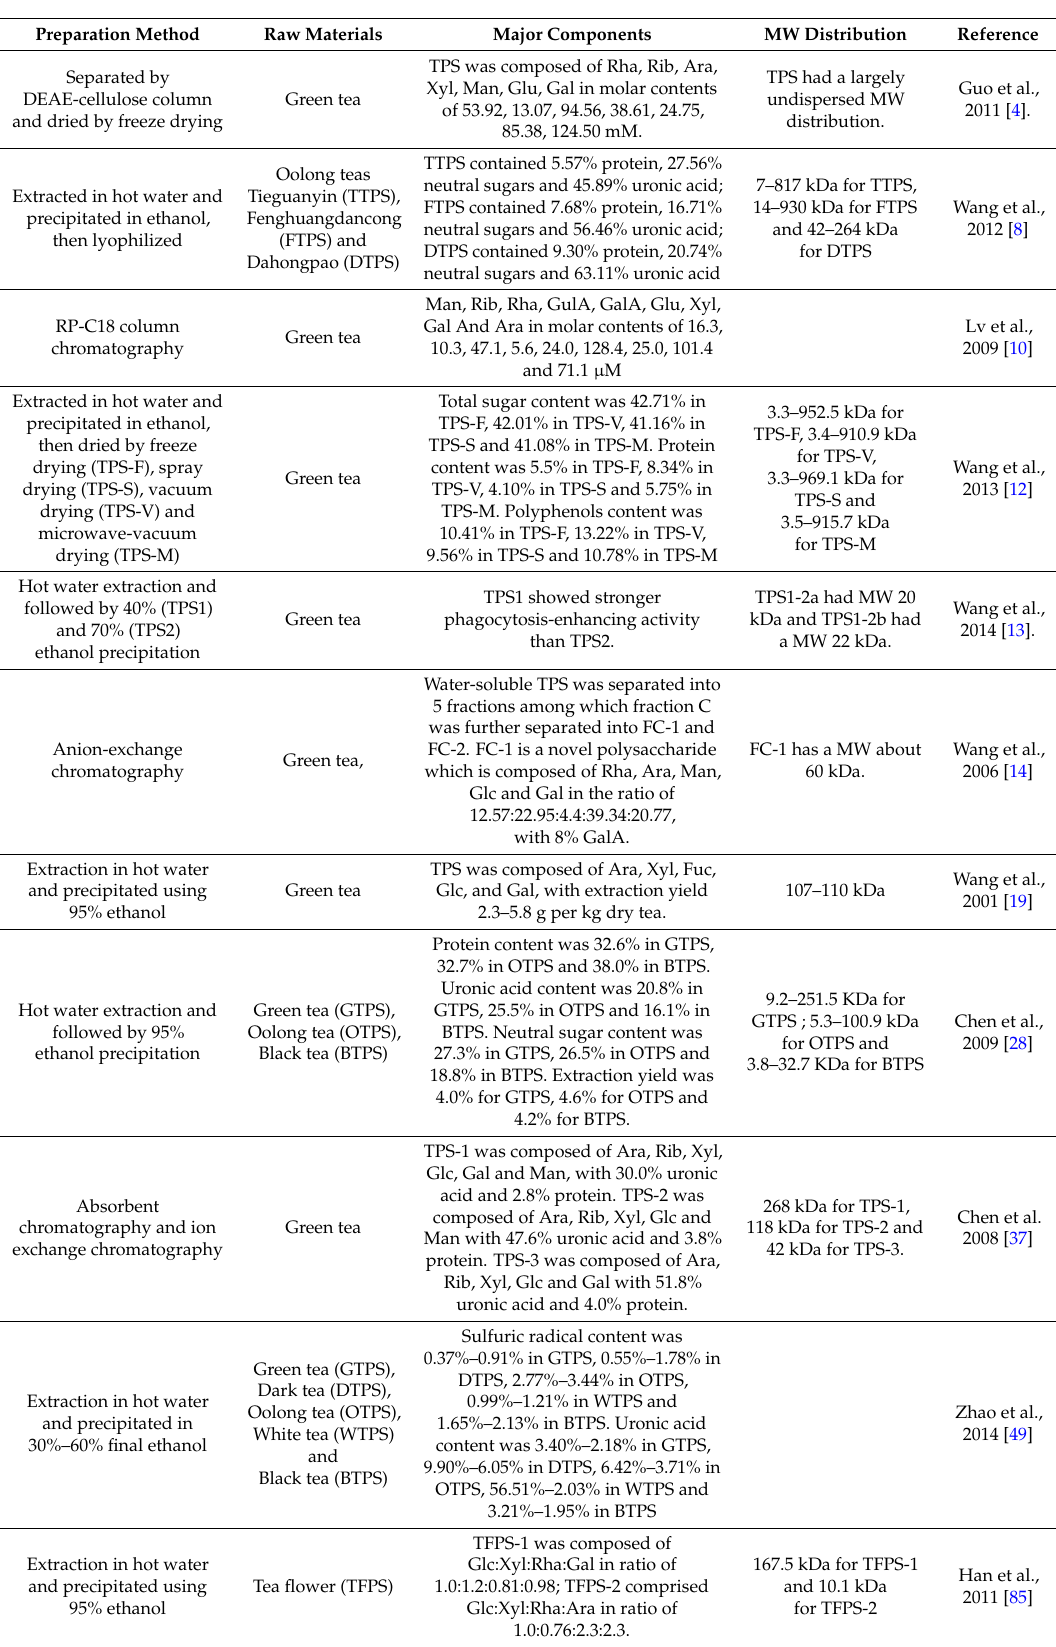
Table 1. Effects of preparation methods and raw materials on chemical composition of